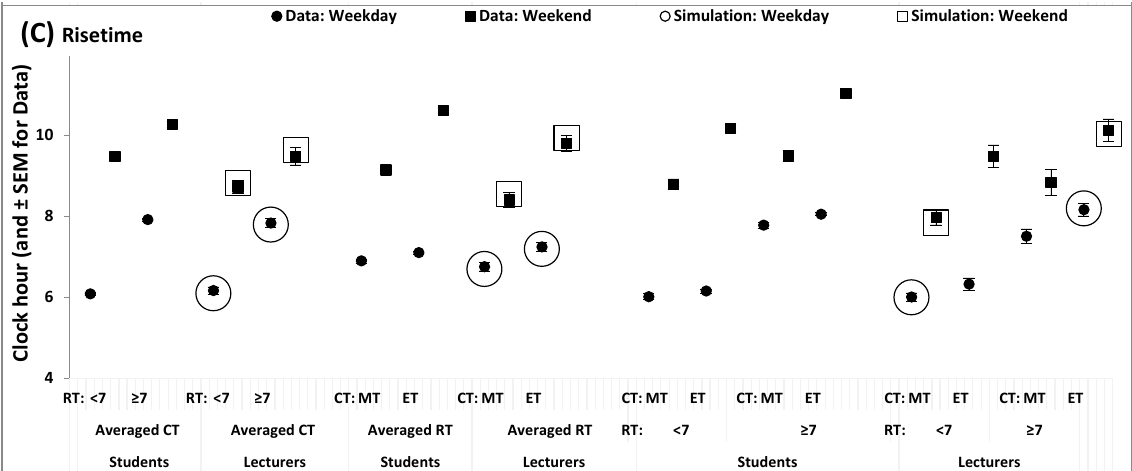
Figure 4. Simulated and self-reported wake intervals and bed- and risetimes. ( A ). Wake interval, ( B ) bedtime, and ( C ) risetime self-reported by survey participants (Table 3, middle and lower parts) in comparison with those obtained as output of simulations of the sequence of 10 sleep–wake cycles for two intervals, the interval of 5 weekdays, and the interval of two following weekends (Figures 1–3 and Tables 2 and 3, upper part).